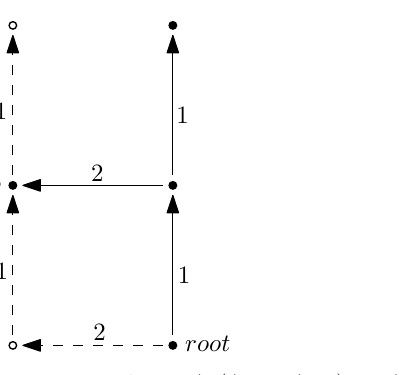
Figure 5. To derive ♦ 1 ( ♦ 2 p ∧ ♦ 1 (cid:62) ) → ♦ 2 ♦ 1 ( p ∧ ♦ 1 (cid:62) ) in K + derive ♦ 1 ( ♦ 2 p ∧ ♦ 1 (cid:62) ) → ♦ 1 ♦ 2 ( p ∧ ♦ 1 (cid:62) ) and then ♦ 1 ♦ 2 ( p ∧ ♦ 1 (cid:62) ) → ♦ 2 ♦ 1 ( p ∧ ♦ 1 (cid:62) )